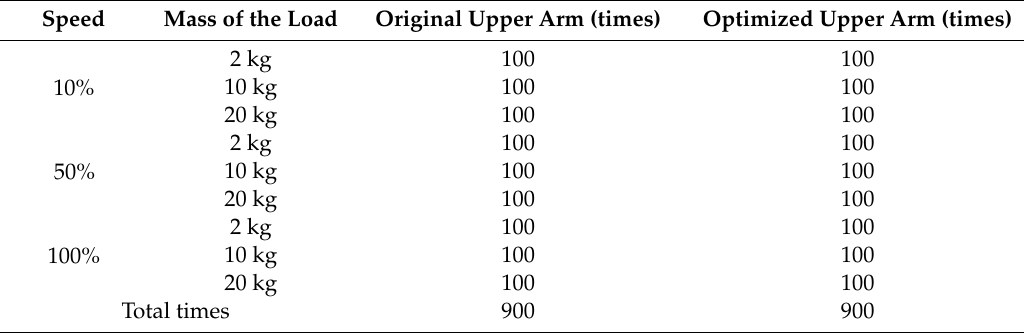
Table 8. The experimental arrangement of the robot with original and optimized upper arms.